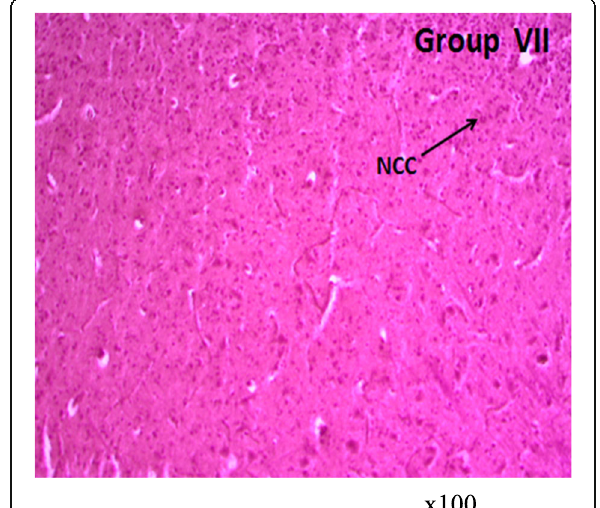
Fig. 7 Photomicrograph of the brain from a bird in group I (control) at the end of 12 weeks. NC neuronal cells; G, support (neuroglial) cells